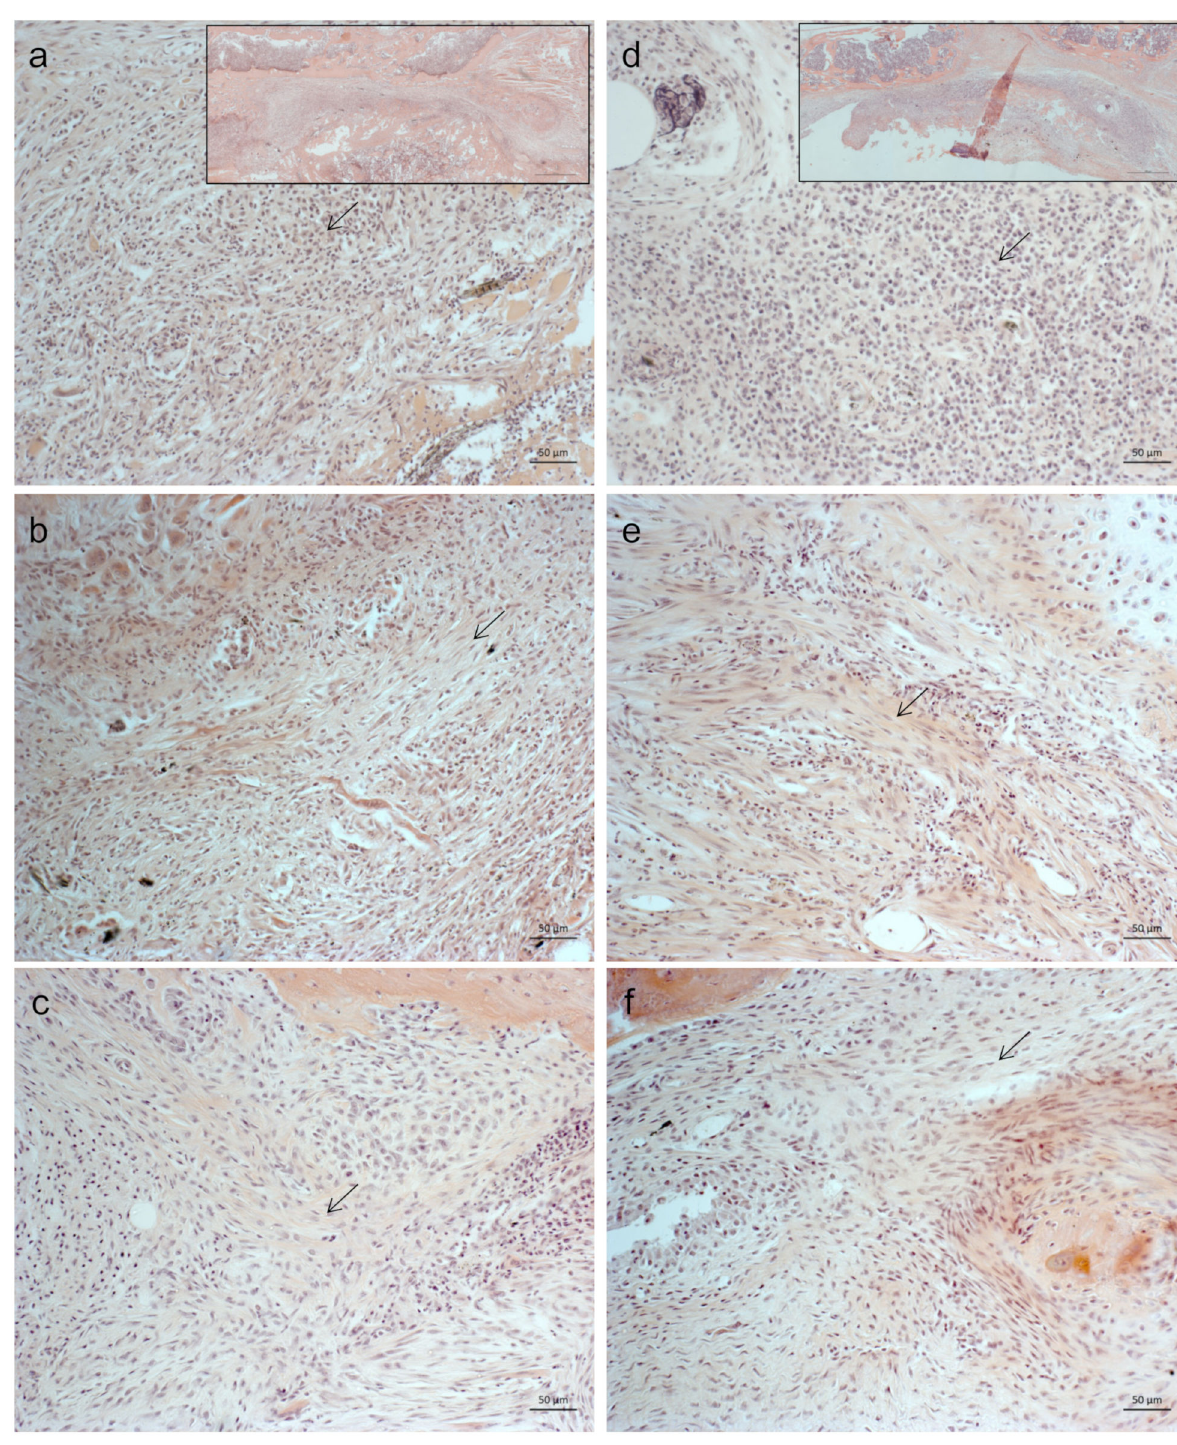
Figure 2. Intermittent Hypoxic Therapy (IHT) mitigates immune-cell infiltration of the allogenic bone- graft tissue of mice. Morphological representative images of hematoxylin- and eosin (HE)-stained histological sections of the allogenic bone-graft area at 1 week ( a – c ) and 4 weeks ( d – f ) for controls ( a , d ), pre IHT ( b , e ), and post IHT ( c , f ). Note that Arrows indicate the superiority of cells within the representative image. Scale bar 50 µ m. The marked squares in the top row of ( a , d ) represent HE stained images of 6- to 10-week old male C57BL/6 mice receiving implantation of 10 mg allogenic bone graft posterior to the lumbar spine (control) after 1 and 4 weeks. Scale bar 500 µ